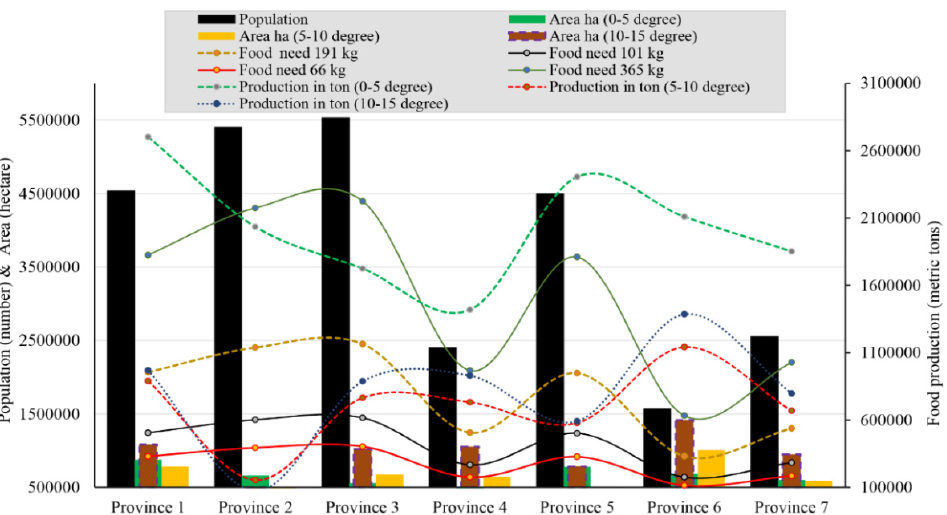
Figure 21. Population, possible agricultural land areas, and production scenarios in seven provinces of Nepal.